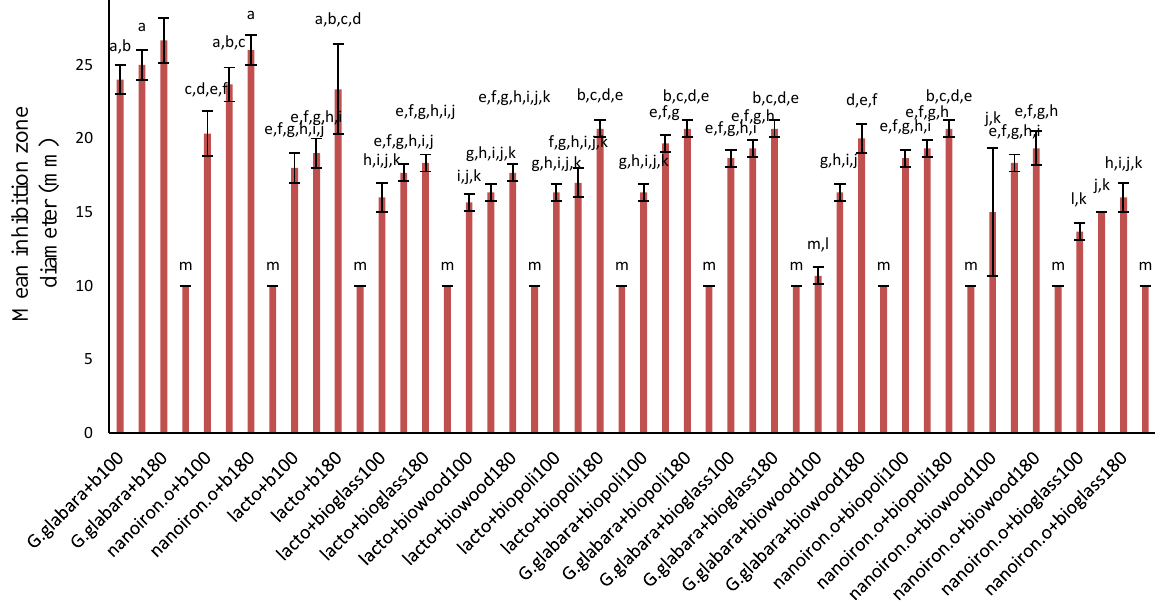
A variety of antimicrobial Fig. 7. Graph of mean changes of growth inhibition zone diameter of P. aeruginosa in different volumes (Different letters indicate significant difference between mean growth inhibition zone diameter due to antimicrobial substances; Similar letters in pattern show significant mean difference between graphs at 0.05; g, h, a: G. glabra + bioglass 100, h, c, d, e : G. glabra + bioglass 180, g, h, i; G. glabra + biowood 100, e, f, g: G. glabra + biowood 180, h, i, b, c, d: nanoiron.o + biopoli 180, f, g, h, I: nanoiron.o + biowood 100, h: nanoiron.o.o + biowood 100, j, k: nanoiron.o + bioglass 100, k: nanoiron.o